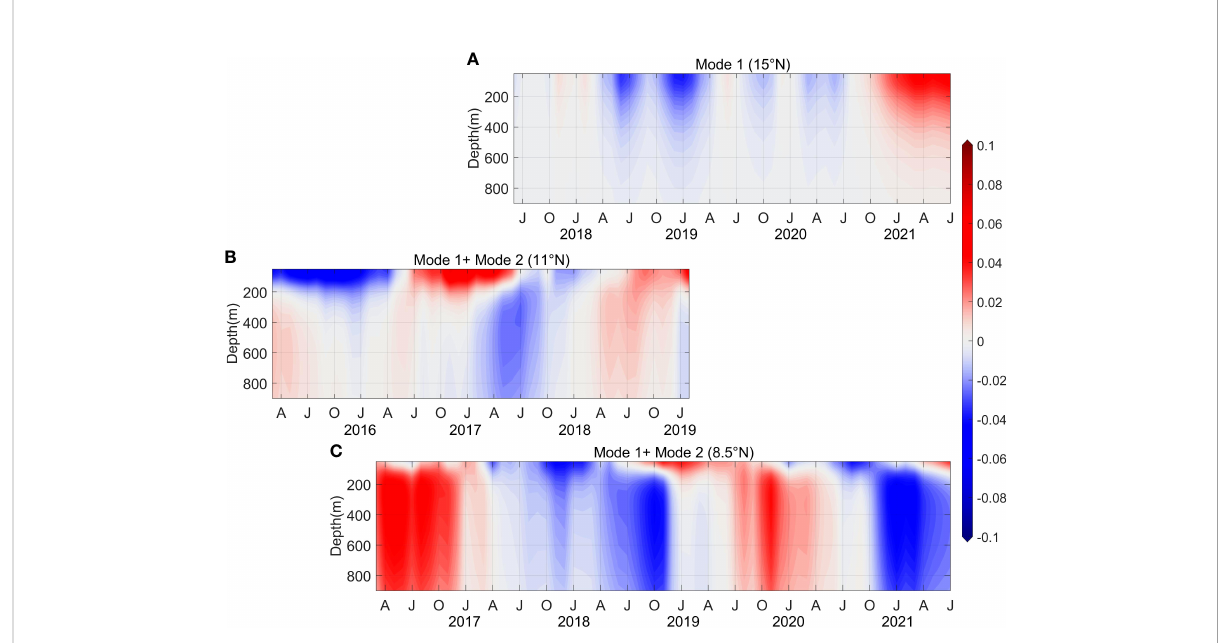
FIGURE 11 Reconstructed zonal velocity (m/s) time series in the upper 900 m during 2015-2021 with the fi rst baroclinic mode at (A) 15°N, with (B) and (C) the fi rst two baroclinic modes at 11°N, and 8.5°N.